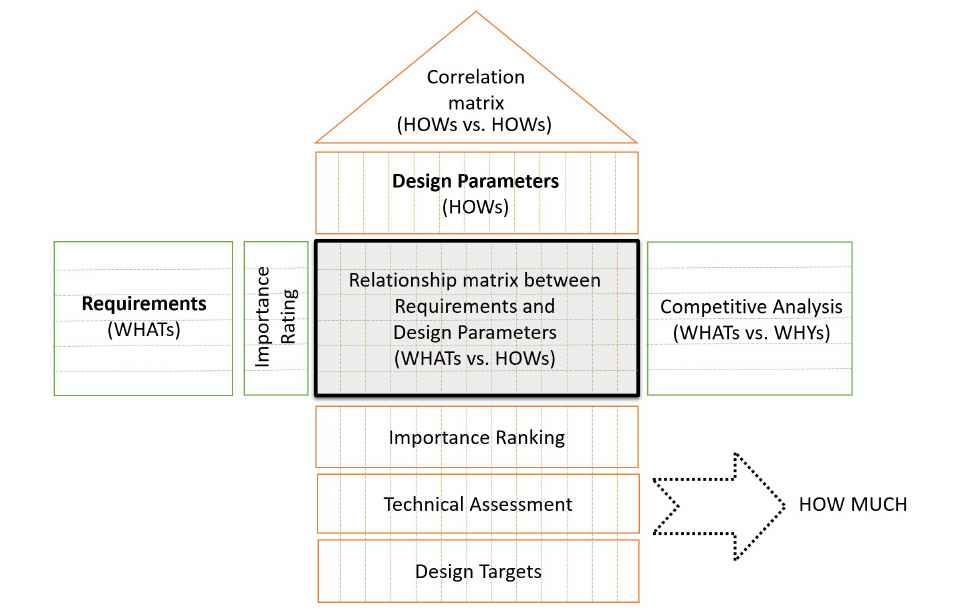
Figure 1. Basic QFD structure or “The House of Quality” based on